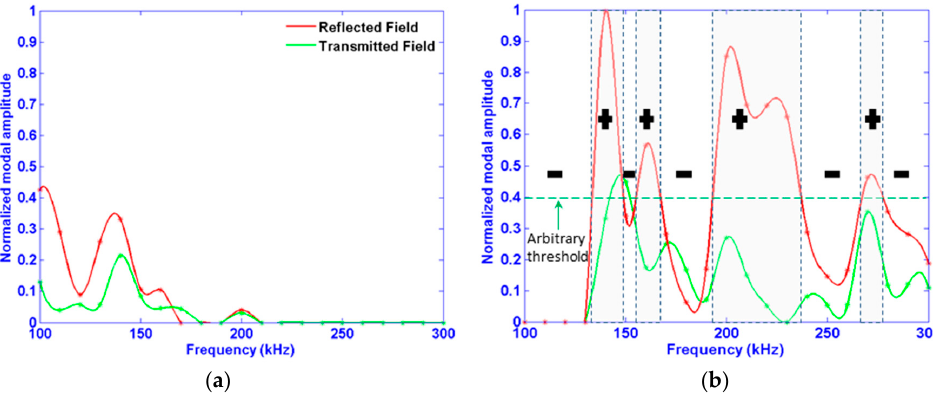
Figure 8. Mode 1 ( a ) and Mode 2 ( b ) amplitudes for the reflected (red) and transmitted fields (green) for a surface-originating crack type defect. All amplitudes are normalized by the maximum of the amplitude of Mode 2. The threshold is chosen arbitrarily to help identify the ( − ) and (+) frequency bands. Stars and continued lines are the collected values and the splined ones, respectively.